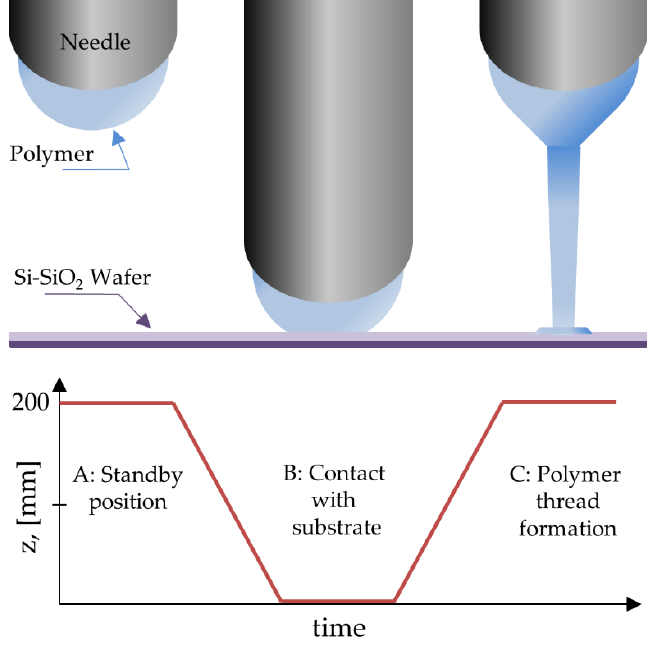
Figure 3. Polymer thread initiation by Contact Low-Voltage Near-Field Electrospinning.